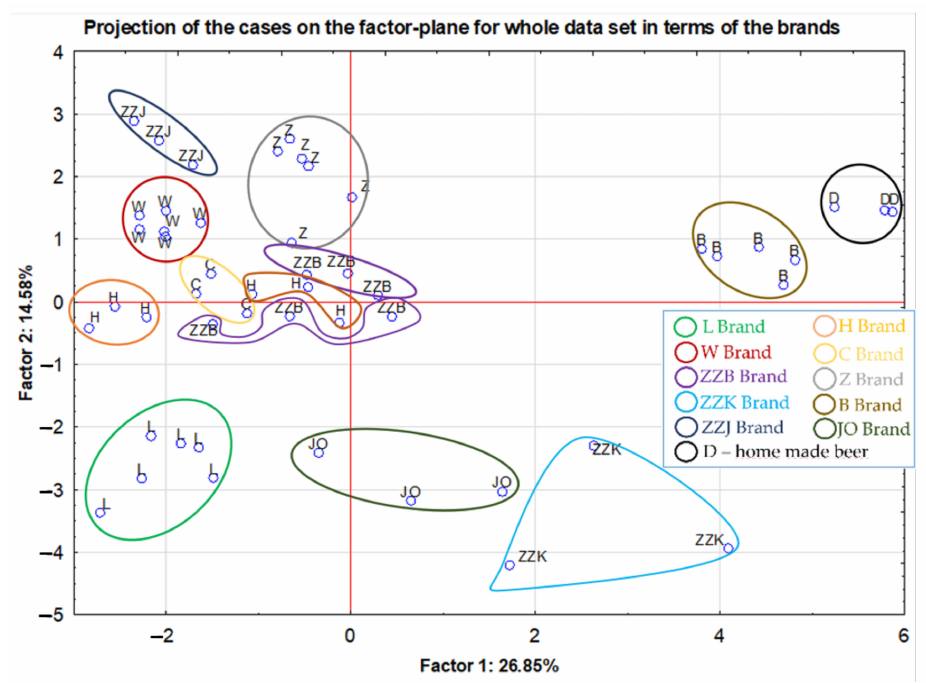
Figure 4. Projection of the cases on the factor-plane for whole data set in terms of the brands.